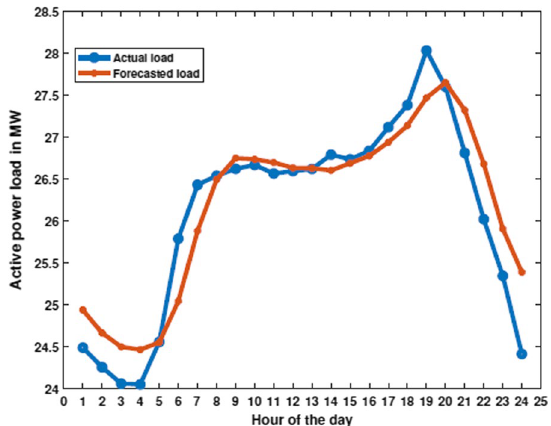
Fig. 2 Forecasted load for TPC distribution system